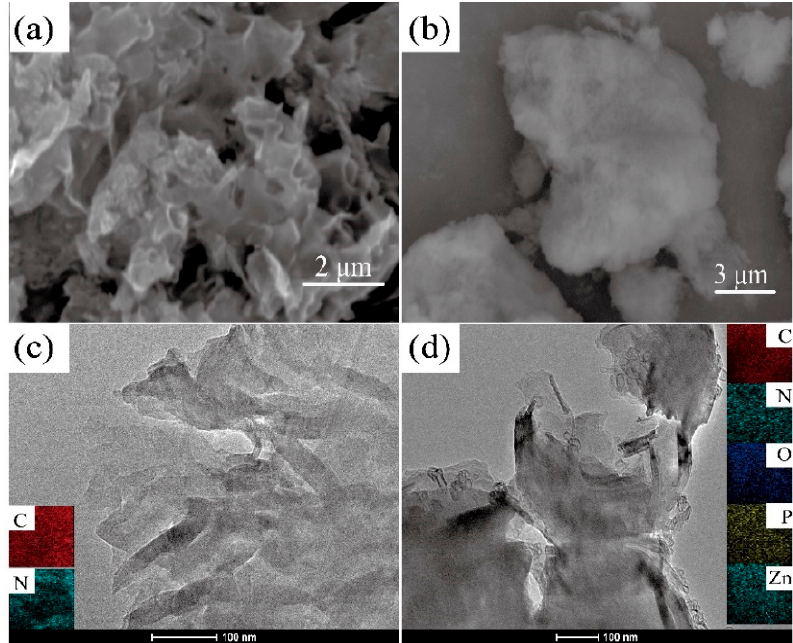
Figure 2. SEM images of g-C 3 N 4 ( a ), g-C 3 N 4 / PAZn ( b ); TEM images of g-C 3 N 4 ( c ) and g-C 3 N 4 / PAZn ( d ).